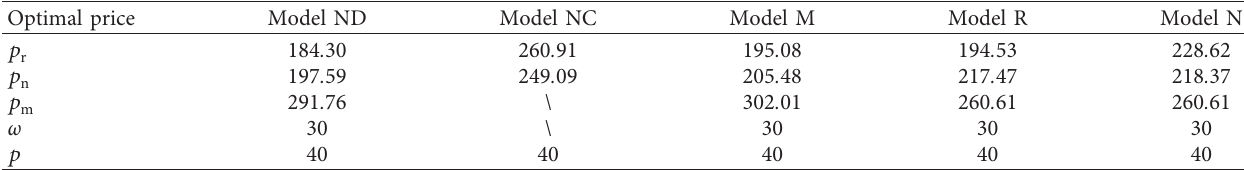
Table 2: Comparison of optimal prices under different